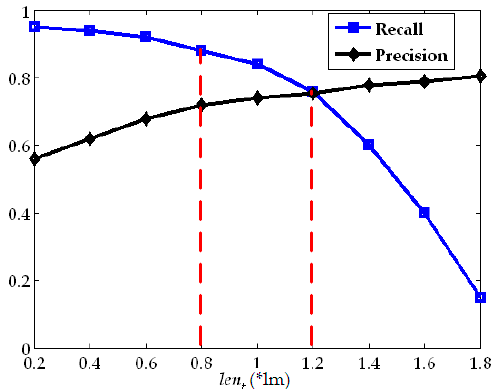
Figure 6. Two evaluation criteria with different length thresholds.